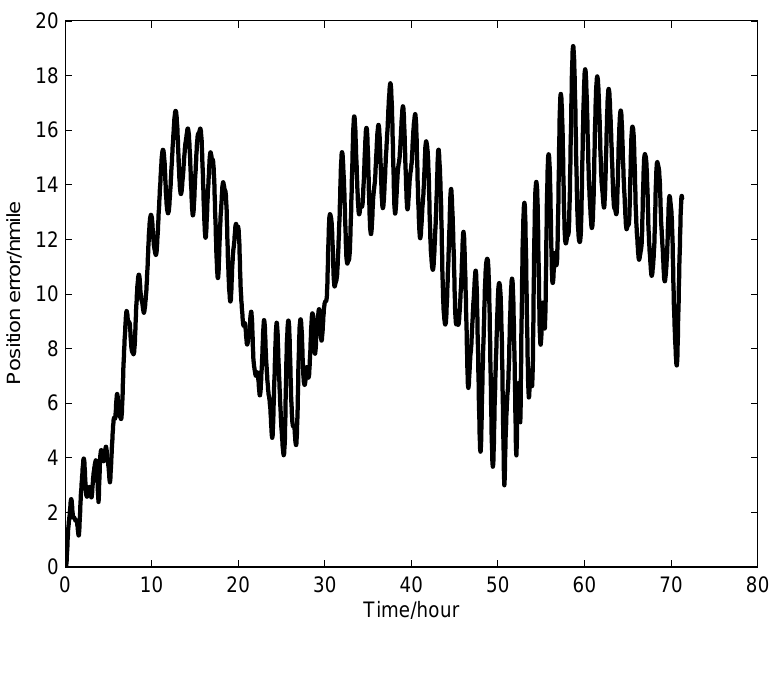
Figure 16. Experimental results (III).